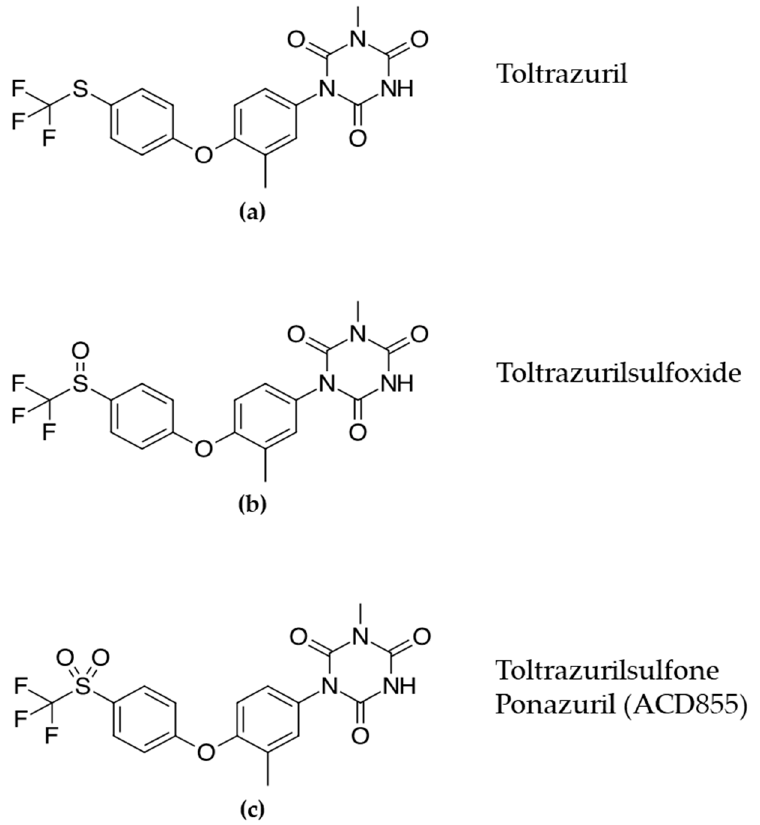
Figure 1. Chemical structure of ( a ) Toltrazuril and its oxidized analogues ( b ) Toltrazurilsulfoxide and ( c ) Toltrazurilsulfone.